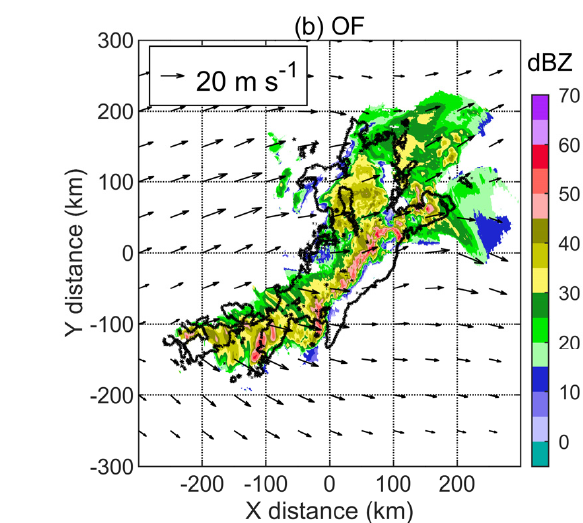
Figure 10. Fifty-seven-minute prediction results. The target time is 15:22 UTC on 17 May 2020. The shading is the predicted CAPPI at a height of 3 km. The black solid lines are the 30 dBZ contours of the convective echo observed at the target time (Figure 8c). The vector fields are obtained by NGT and OF for backward interpolation. ( a ) NGT; ( b ) OF.